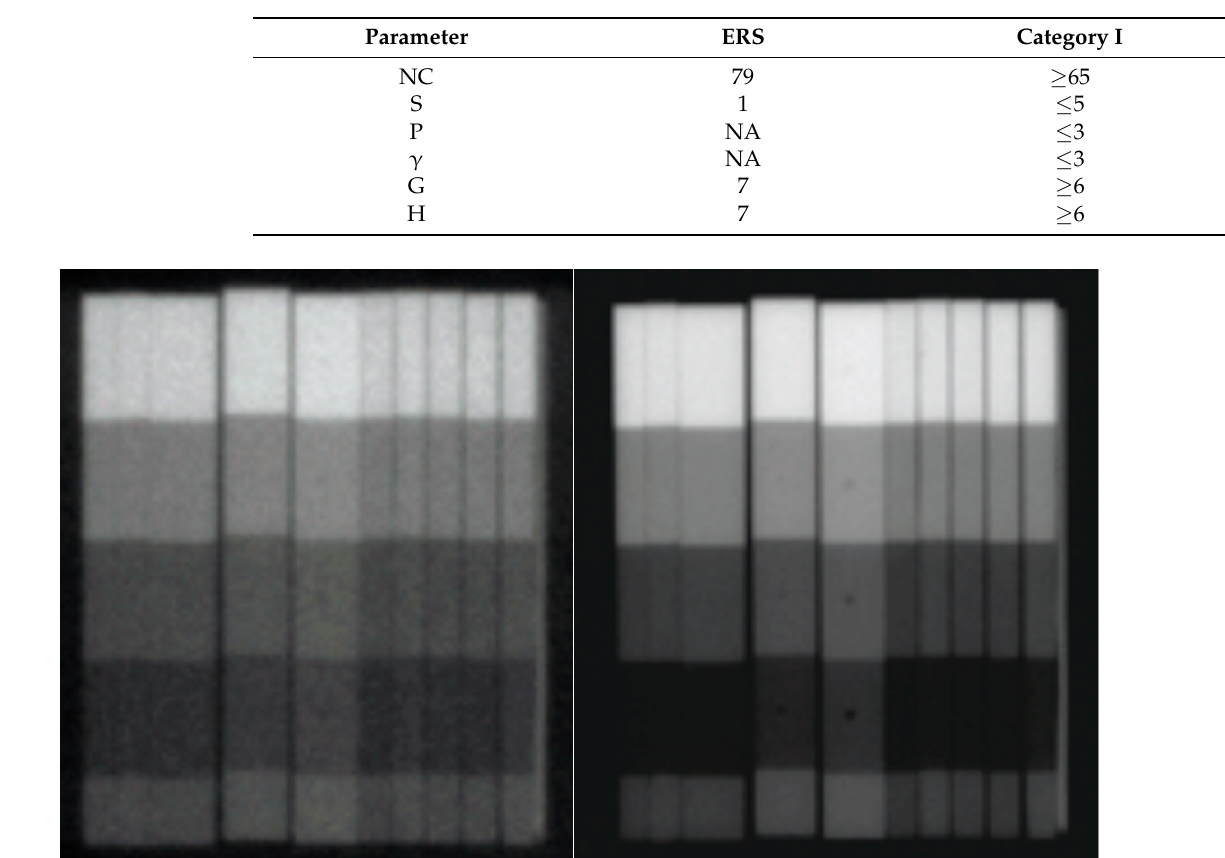
Figure 5. Neutron radiographs of IQIs using ( left ) an indium foil (epithermal) radiograph and ( right ) a dysprosium foil (thermal) radiograph.